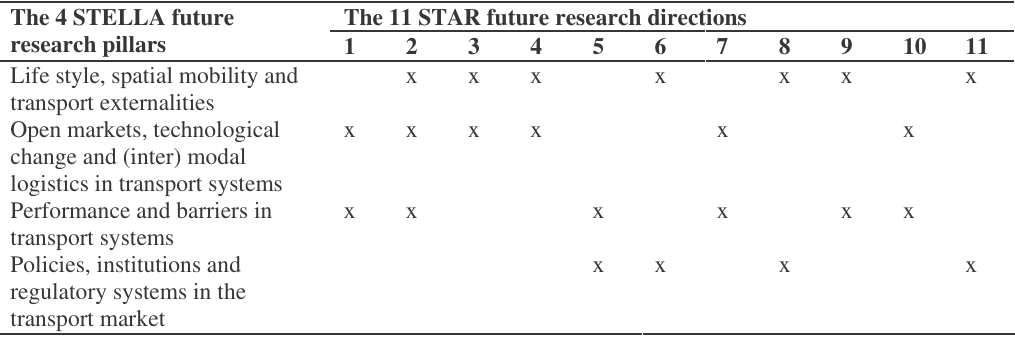
Table 1. The allocation of 11 STAR research directions over the 4 STELLA research